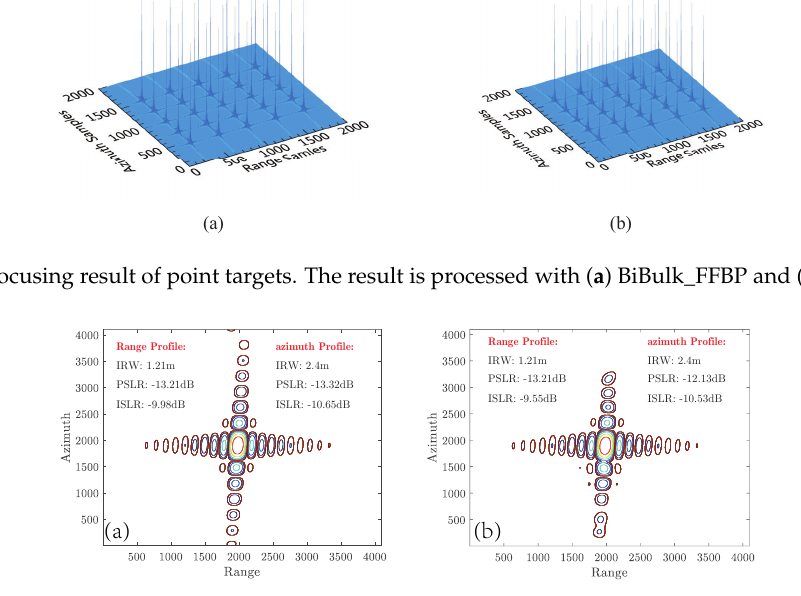
Figure 14. Extended target contours. The result is processed with ( a ) BiBulk_FFBP and ( b ) FBP in